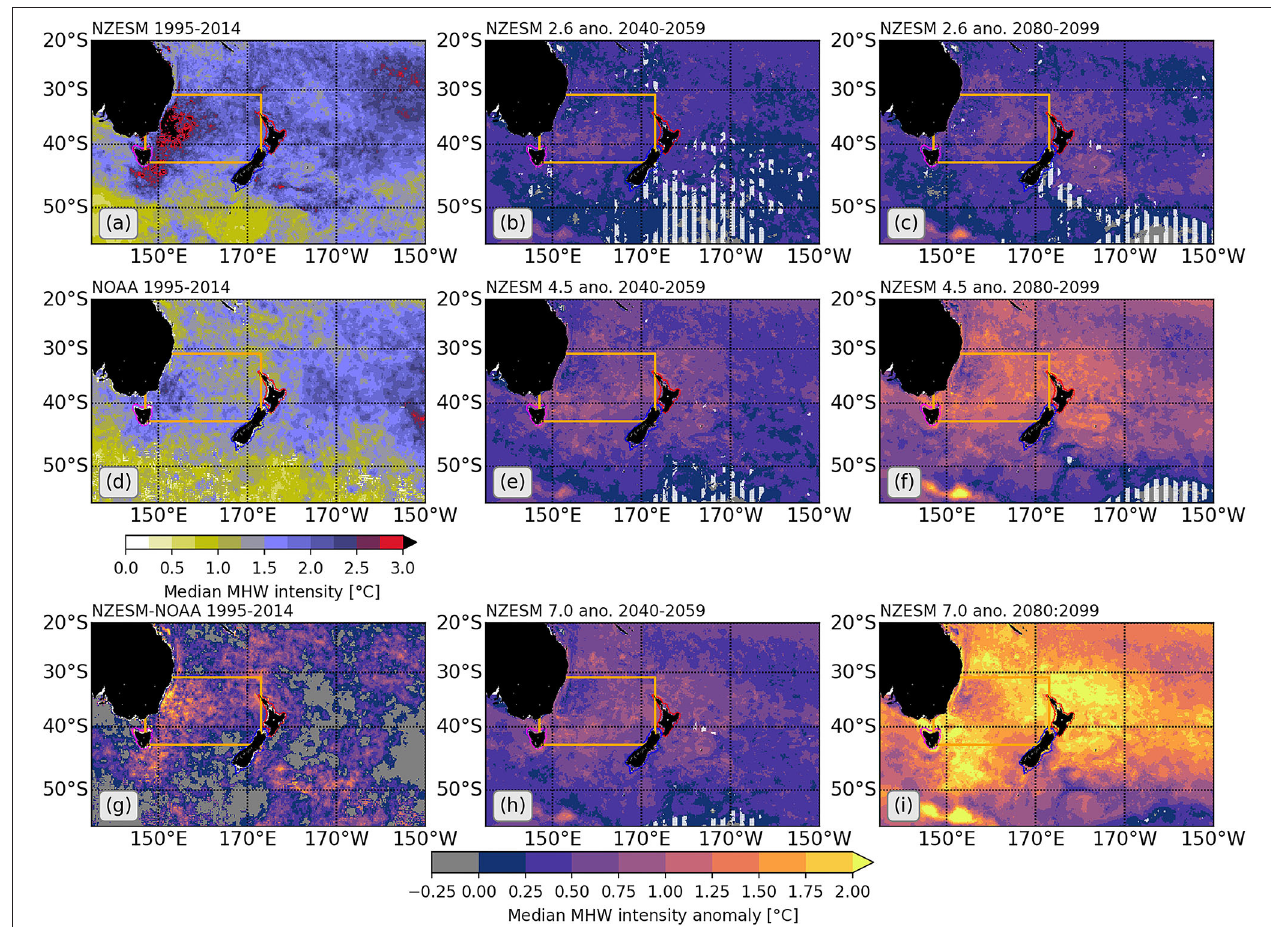
FIGURE 1 | Median MHW intensities for 1995–2014. (a) NZESM ensemble, (d) NOAA OI-SST and (g) the anomaly between NZESM ensemble and NOAA OI-SST. NZESM projected changes of median MHW intensity relative to 1995–2014: for SSP 2.6 in (b,c) for 2040–2059 and 2080–2099, respectively; for SSP 4.5 in (e,f) for 2040–2059 and 2080–2099, respectively; for SSP 7.0 in (h,i) for 2040–2059 and 2080–2099, respectively. Each panel of model data represents results of a 60 year member ensemble i.e., 20 years of data from each of the three-ensemble members. The white hatched regions indicate regions where change in median MHW intensity is not significant ( p > 0.01) compared to the historical reference period. The orange box indicates the Tasman Sea, while the coastal regions around North and South Island of New Zealand, and Tasmania, are illustrated by the red, blue and magenta dotted lines, respectively. A detailed map of the coastal regions and grid boxes which characterize these regions is provided in the Supplementary Figure S4